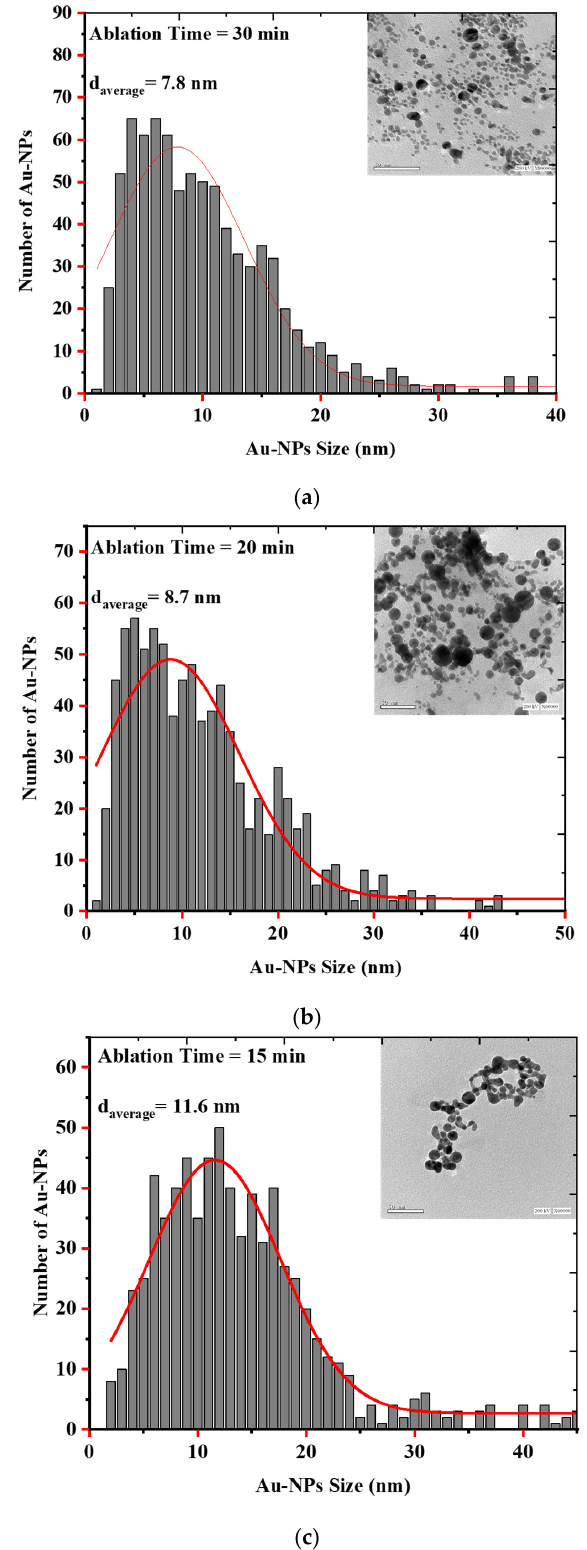
Figure 4. EM images and histograms of the AuQD size distribution produced by laser ablation in distilled water (LAL- DW) using a 100 mJ laser pulse energy and different ablation times of ( a ) 30 min, ( b ) 20 min, and ( c ) 15